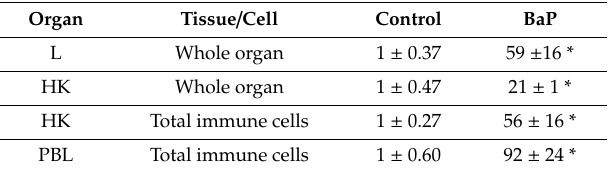
cyp1a gene expression levels in liver (L), head kidney (HK), immune cells isolated from head kidney and immune cells isolated from peripheral blood (PBL) of BaP-exposed rainbow trout relative to control fish. Data were analyzed using the 2 −(∆∆ct) method. Gene expression levels in organs and cells of BaP-exposed trout were compared to the mRNA levels in the respective organs and cells of the control trout, which were set to be 1. Data represent mean values ± SD from 10 fish per treatment. Asterisks indicate significant differences to control ( p < 0.05). PBL = peripheral blood immune cells. In order to test if the CYP1A induction is mediated through the AhR pathway, we exposed cultured head kidney immune cells to BaP or to BaP in combination with the AhR antagonist, ANF (BaP + ANF). Presence of ANF significantly reduced the BaP-dependent upregulation of cyp1a mRNA (Figure 3).